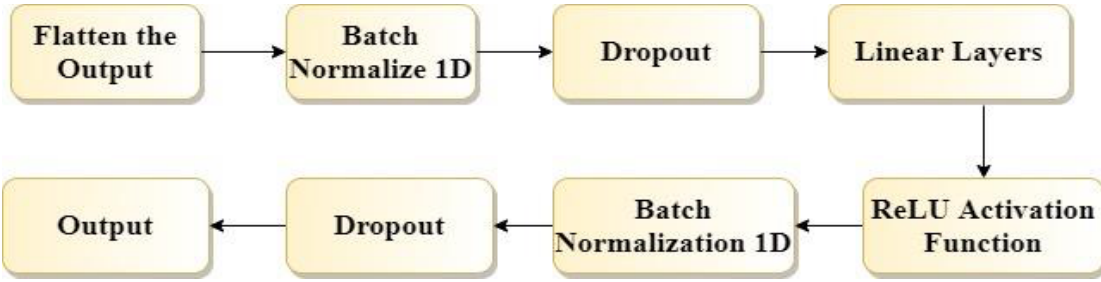
Figure 3. Flow chart of fully connected layers of the proposed model.